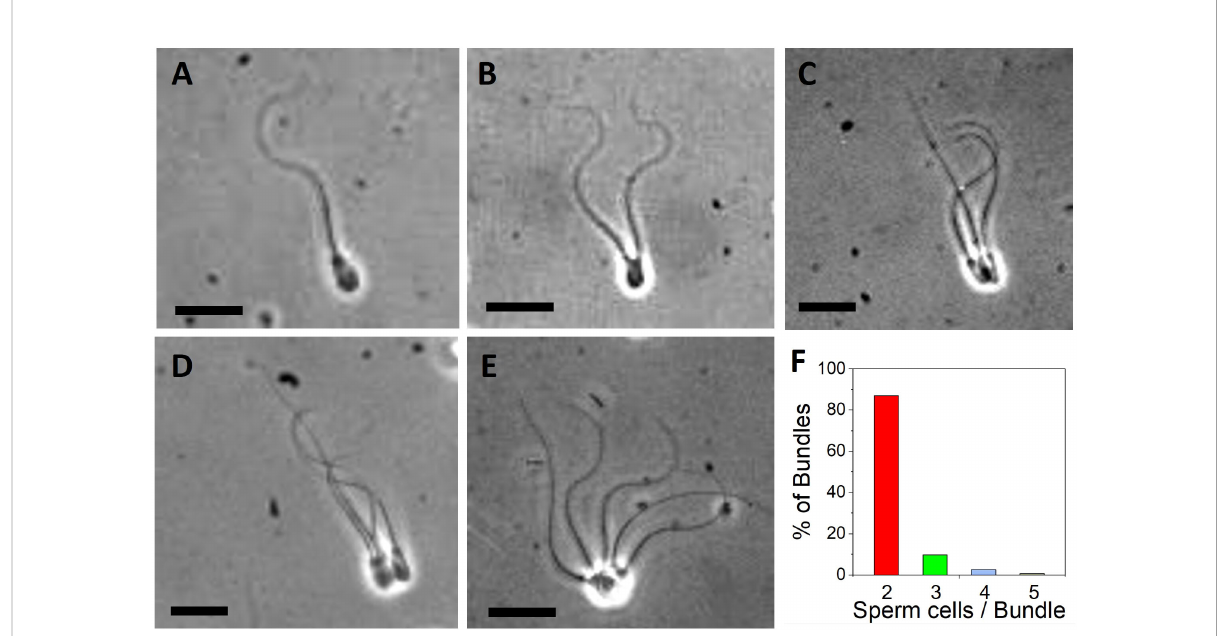
FIGURE 1 Images of bovine sperm bundles obtained from videomicroscopy. (A) Single sperm cell. Bundle with (B) 2 cells (C) 3 cells (D) 4 cells (E) 5 cells. Video 1 – 4 show representative cases. Scale bars are 20 µm. (F) Distribution of observed bundles depending on the number of sperm cells per bundle (2, 3, 4 and 5 cells per